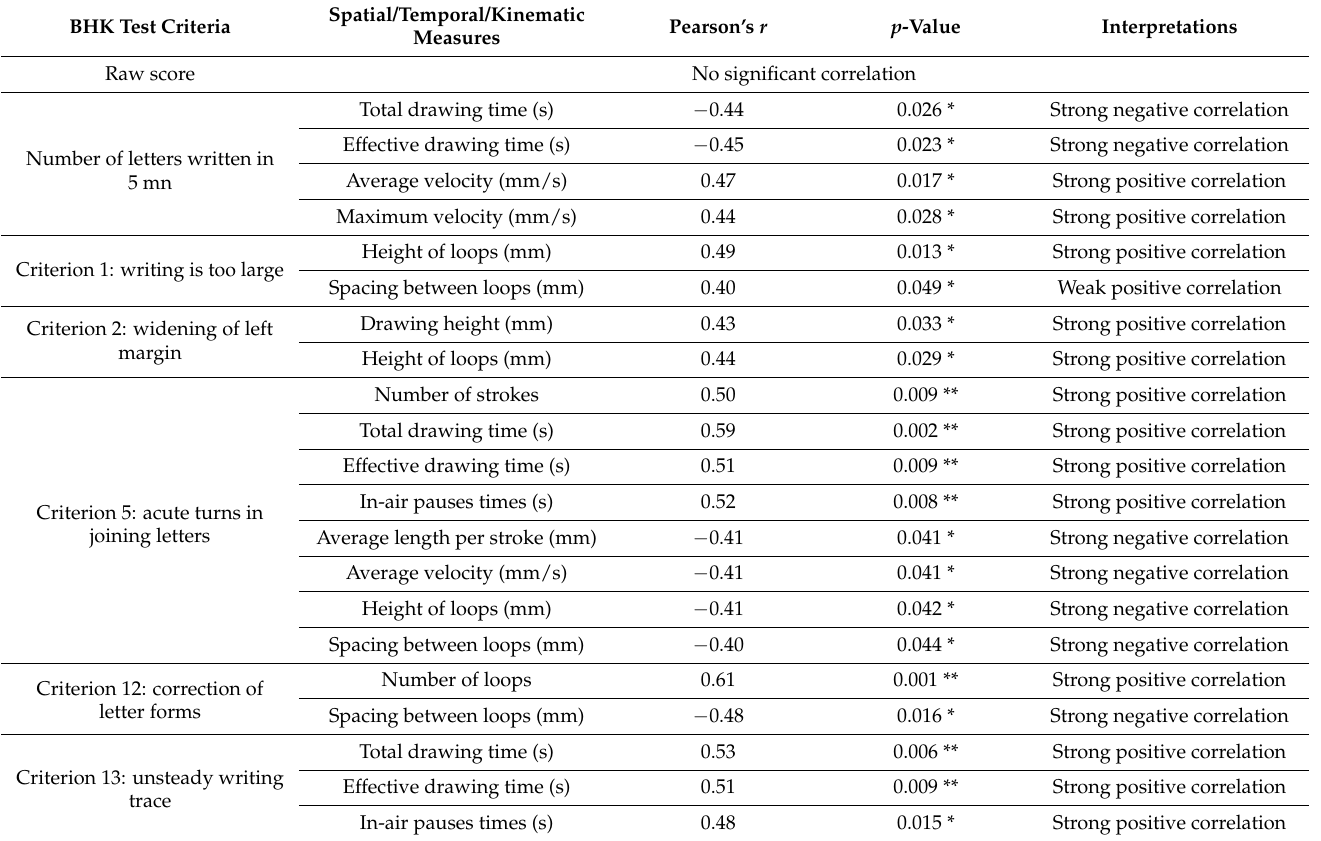
Table 4. Statistically significant correlations between BHK scale scores and spatial/temporal/kinematic measures for copying a line of cycloid loops ( n =